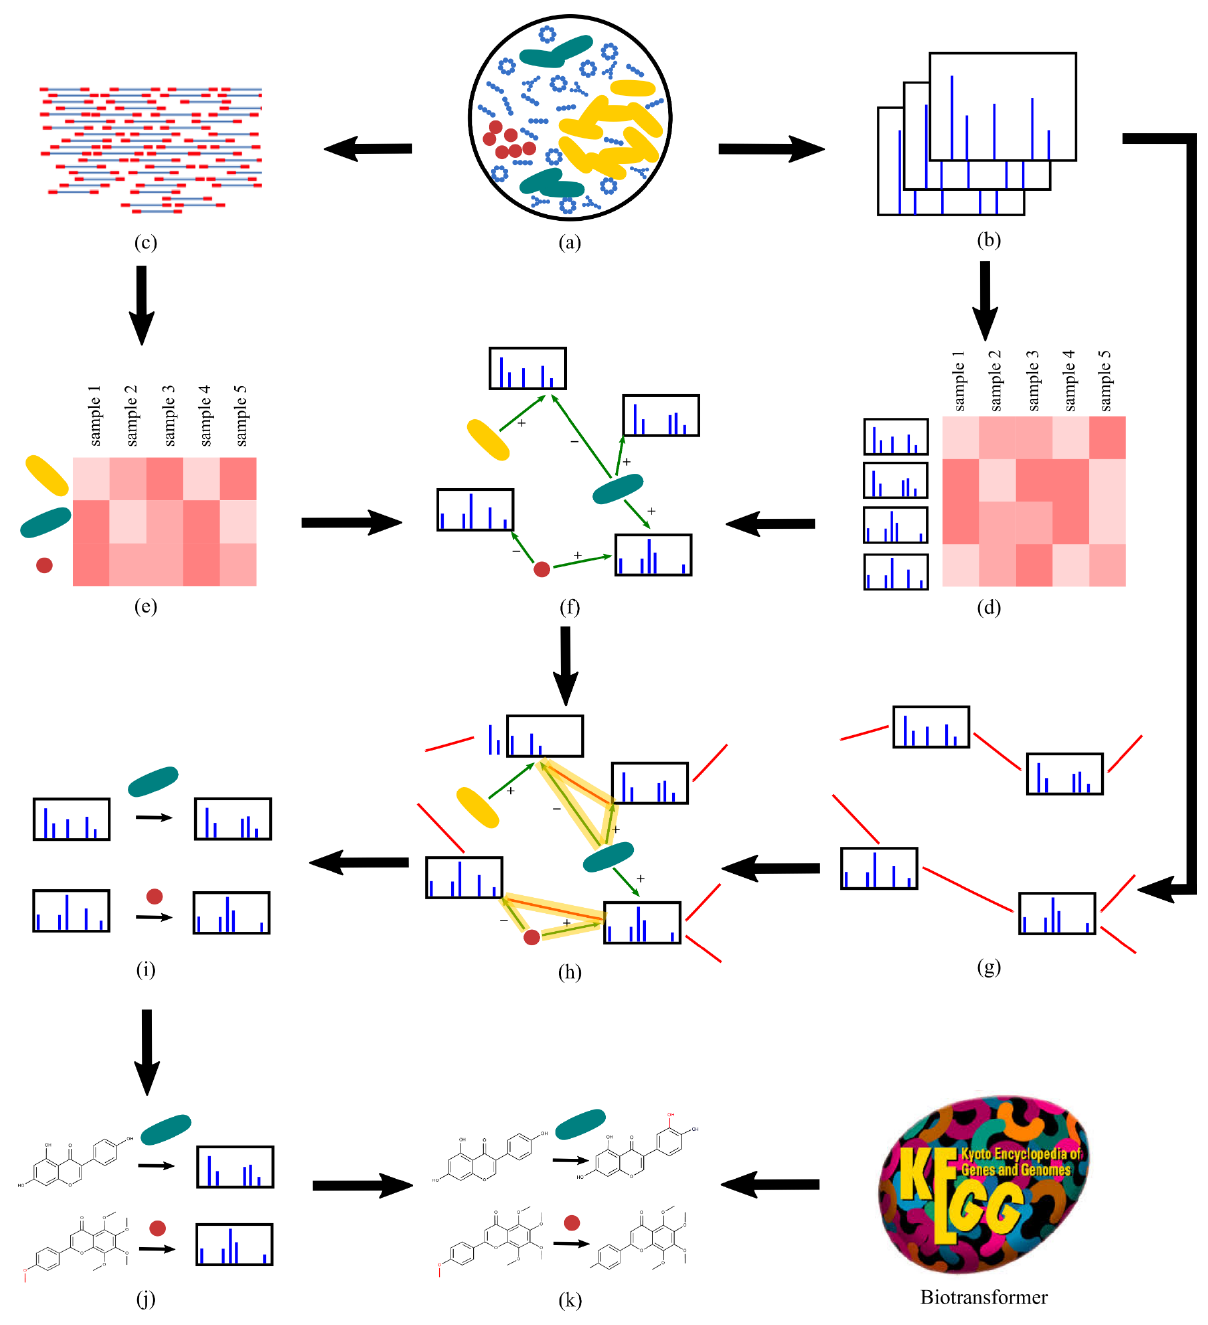
Figure 1. TransDiscovery framework for discovering novel biotransformations of human dietary in- gredients by ( a ) the gut microbiome. Starting with ( b ) the mass spectral data of small gut molecules and ( c ) metagenomics data of gut microbes, the pipeline includes the following steps: extracting ( d ) molecular and ( e ) microbial features from raw data, ( f ) constructing an association network [26–28] of molecular and microbial features (edges shown in green), ( g ) constructing a molecular network [30] (edges shown in red), ( h ) integrating associations and the molecular network, ( i ) extracting candidate biotransformations as golden triangles, ( j ) identifying substrates of biotransformations with an in silico database search with Dereplicator+ [31], and ( k ) characterizing molecular products of known biotrans- formations using in silico predictions of BioTransformer [29]. Note that in steps ( f , h – k ), the nodes can represent either strains or enzymes. In steps ( f , h ), the plus and minus labels indicate that the substrate is negatively correlated with the microbial feature and the product is positively correlated with the microbial